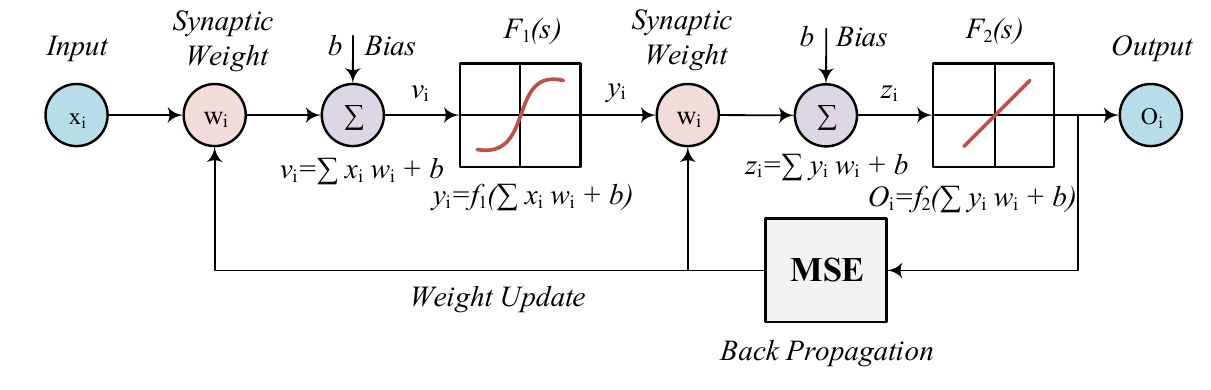
Figure 7. Schematic structure of ANN for